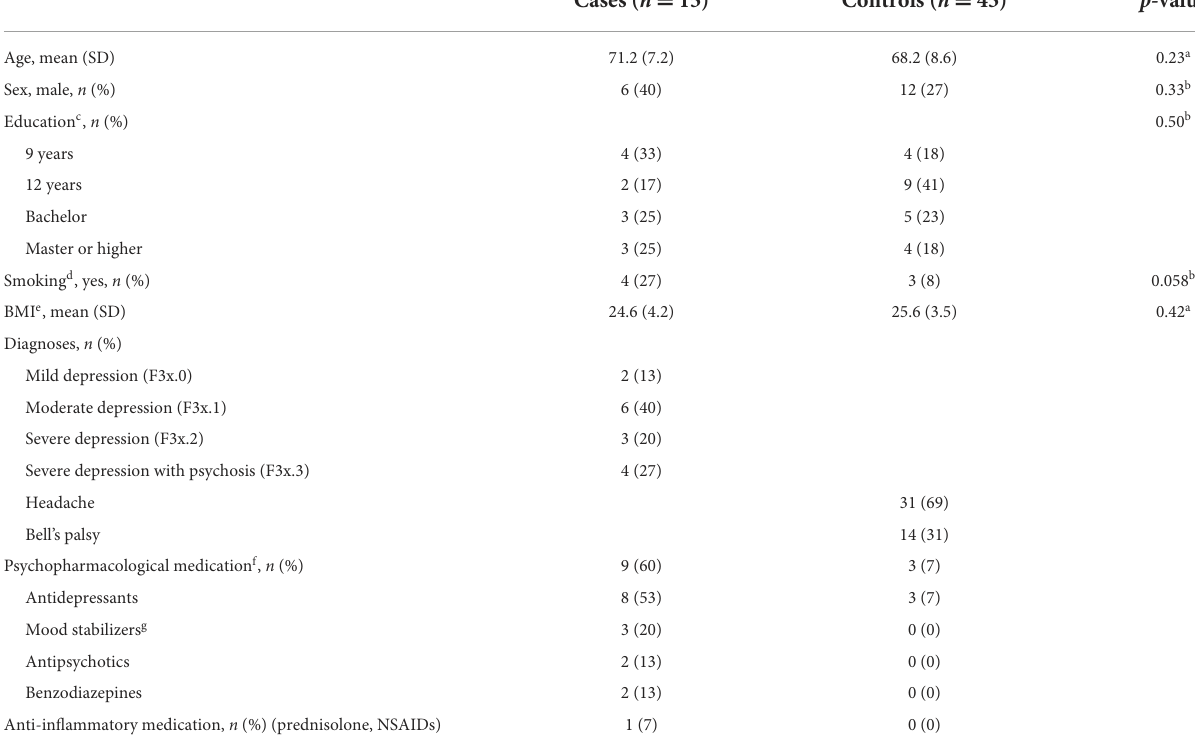
TABLE 1 Demographic and clinical characteristics of the study